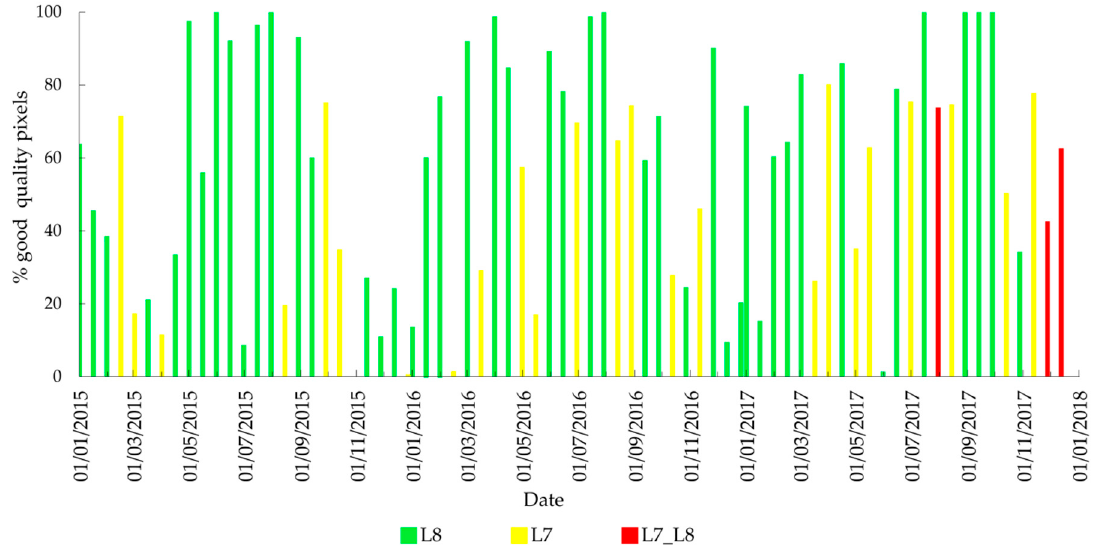
Figure 3. Percentage of good-quality pixels in the study area on all 15-day Landsat composites used in this study.